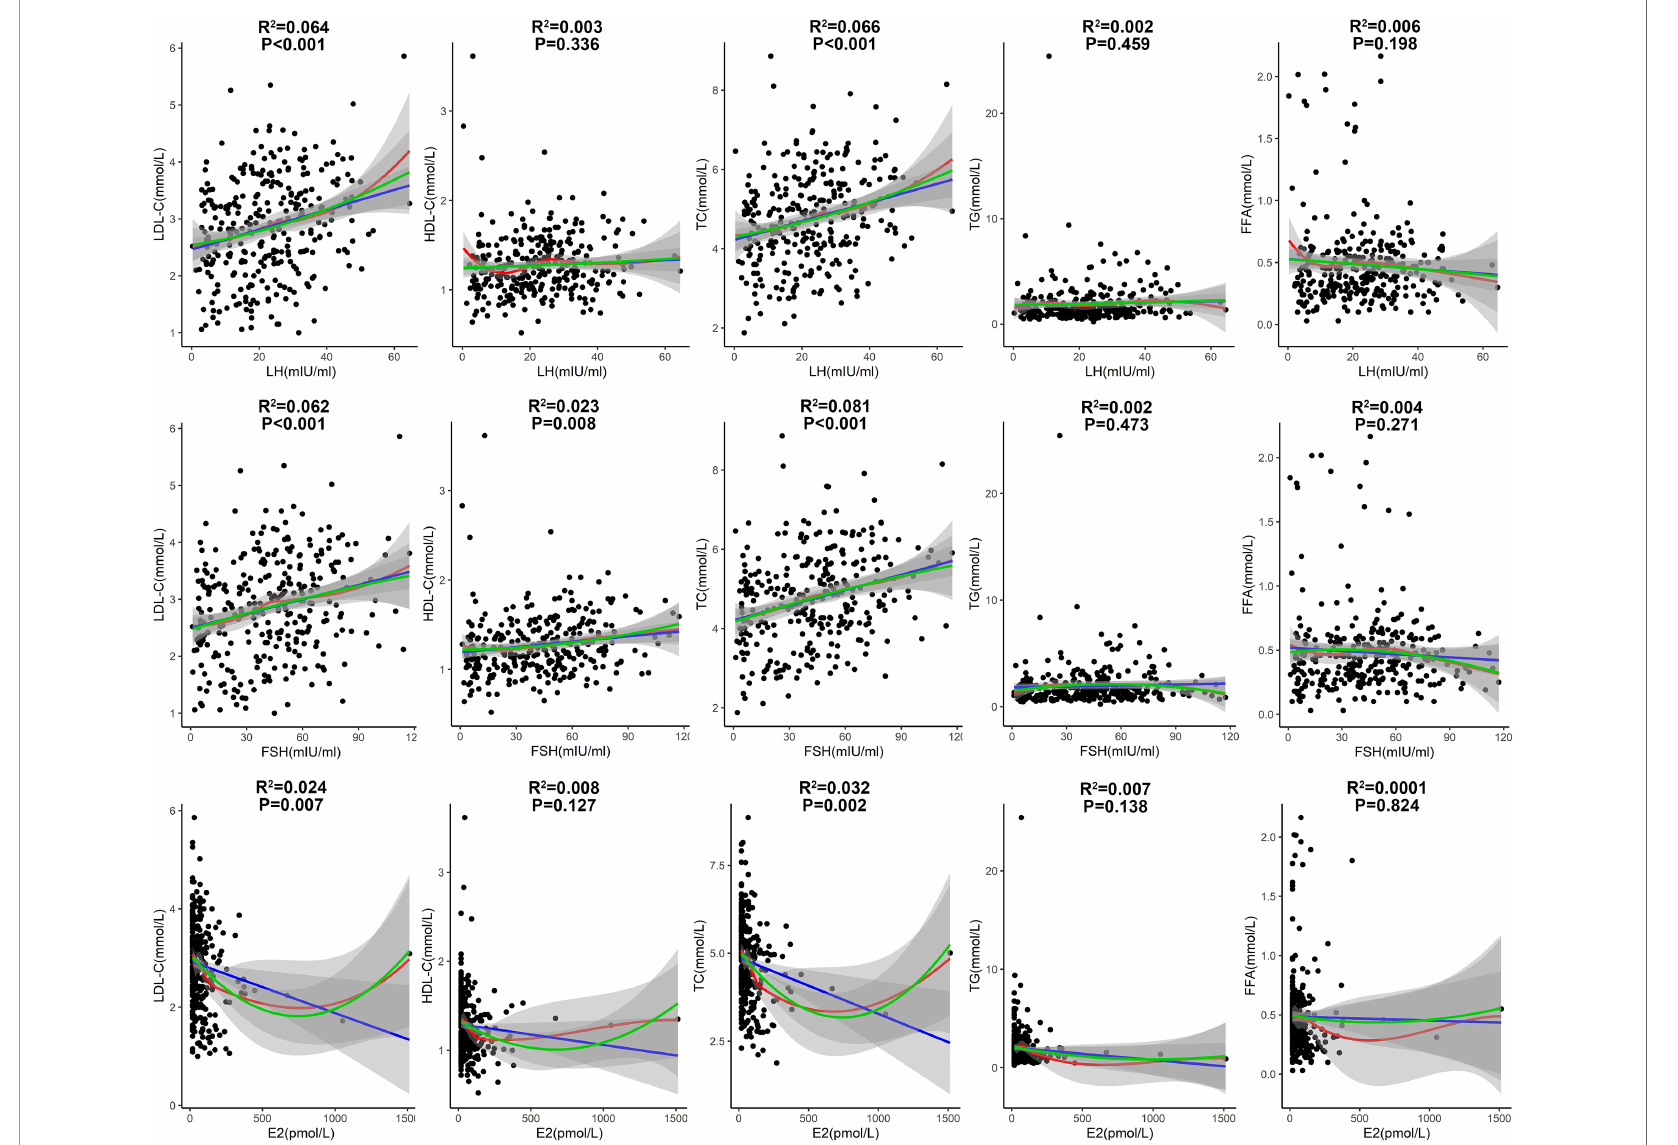
FIGURE 5 | Correlations of lipid pro fi le with LH, FSH and E2 in patients with T2DM aged 51-60 years. (Fitted curves of linear model are shown in blue; smoothing fi tted curves of LOESS model are in red; fi tted curves of binary linear regression model are in green. Adjusted R 2 and P values from the linear model are shown in the fi